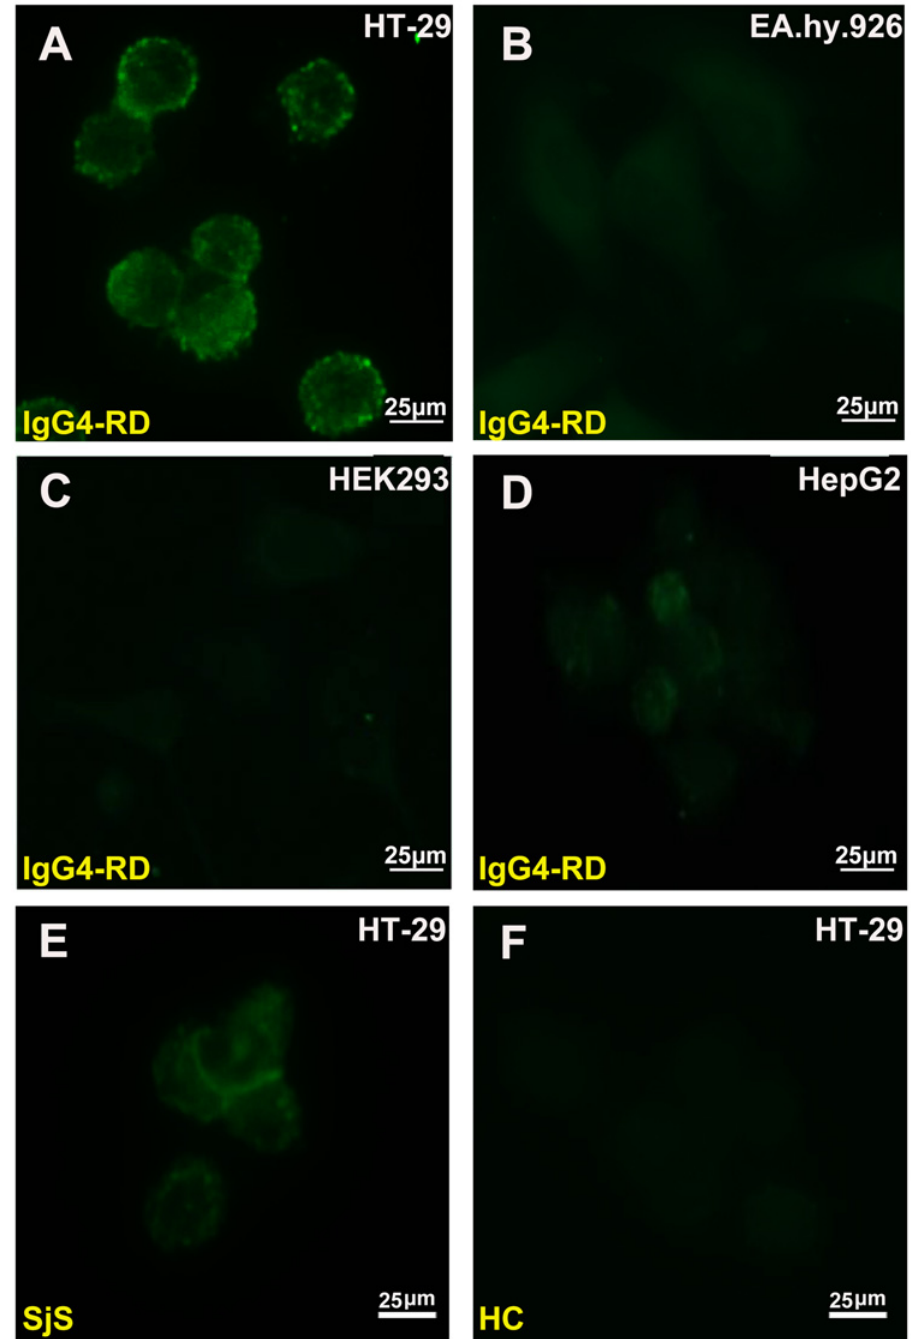
Fig 1. Immunofluorescence analysis. (A-D) Immunofluorescence was performed on HT-29 by confocal laser microscopy, then compared with other cells including EA.hy926, HEK 293 and HepG2. Total cell fluorescence was analyzed by Image J software and significant differences were found between HT-29 and three other cell lines ( p < 0.0001), indicating positive reactions in HT-29 cells with IgG4-RD sera. (E-F) Control samples including SjS and HC were then tested on HT-29 cells, and the sera of patients with SjS were found to have a weaker specific reaction and no positive signal on